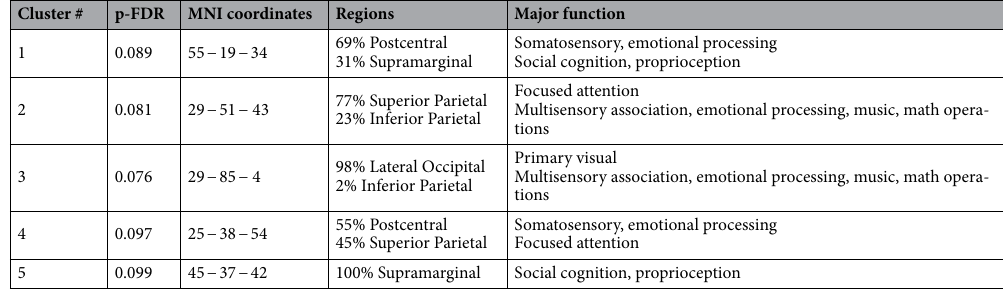
Table 2. Details of significant clusters from Fig. 1. Corrected p -value, location, atlas labels and major function of clusters with lower cortical thickness (CT) correlated with higher ScreenQ scores controlling for child sex and age, shown in Fig. 1A (thresholds: two-sided p-FDR < 0.10 and p-FDR < 0.05). Montreal Neurological Institute (MNI) coordinates are left–right, posterior-anterior and inferior-superior relative to the anterior commissure. Regions indicates the percentage of each cluster residing in the respective Desikan-Killiany DK40 atlas-defined area.